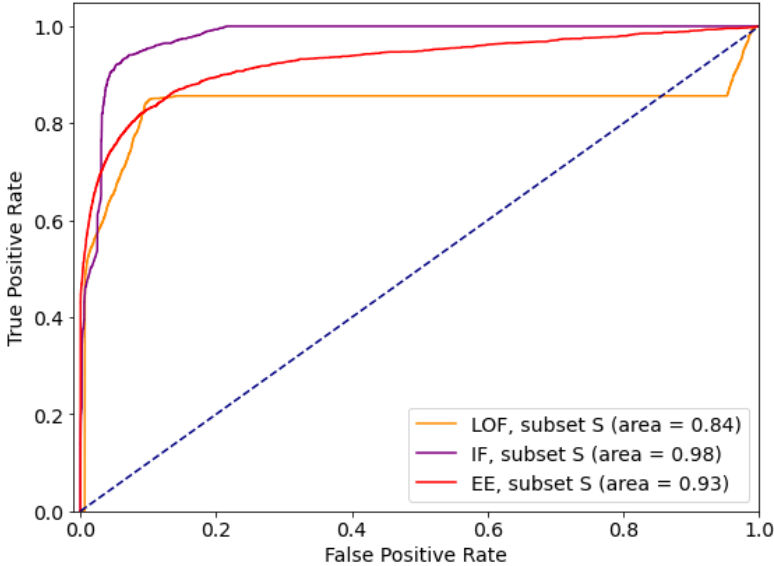
Figure 14. Extended BankSim dataset—comparative ROC curve for outlier detection methods.